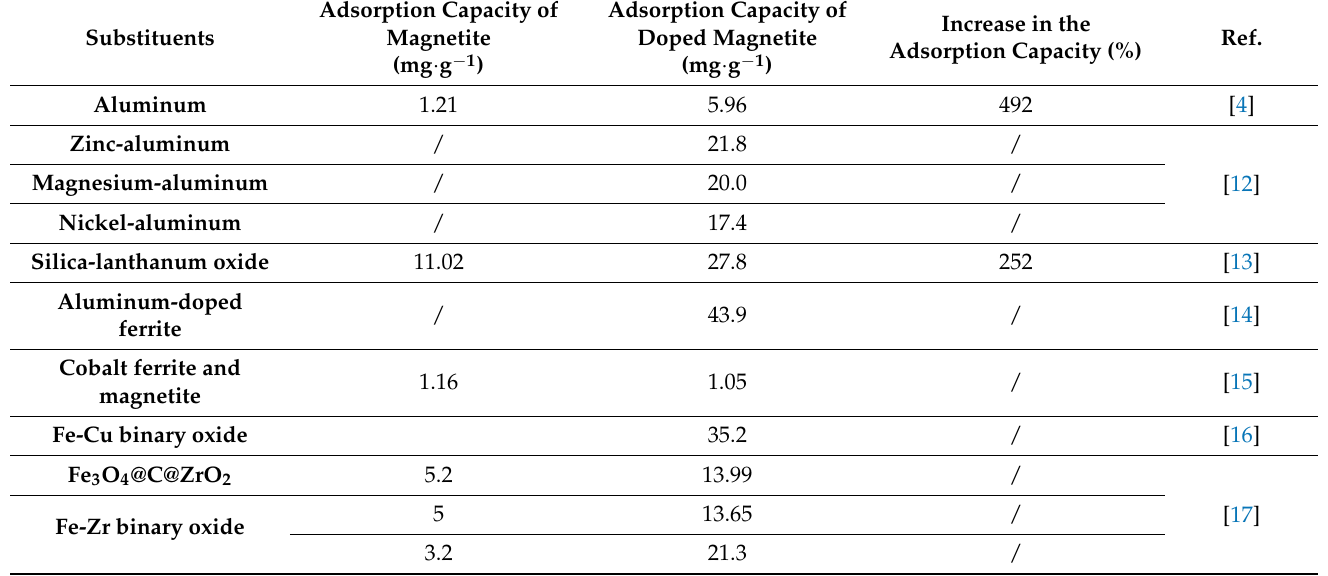
Table 1. Influence of the substituents on magnetite adsorption capacity towards phosphates in aqueous